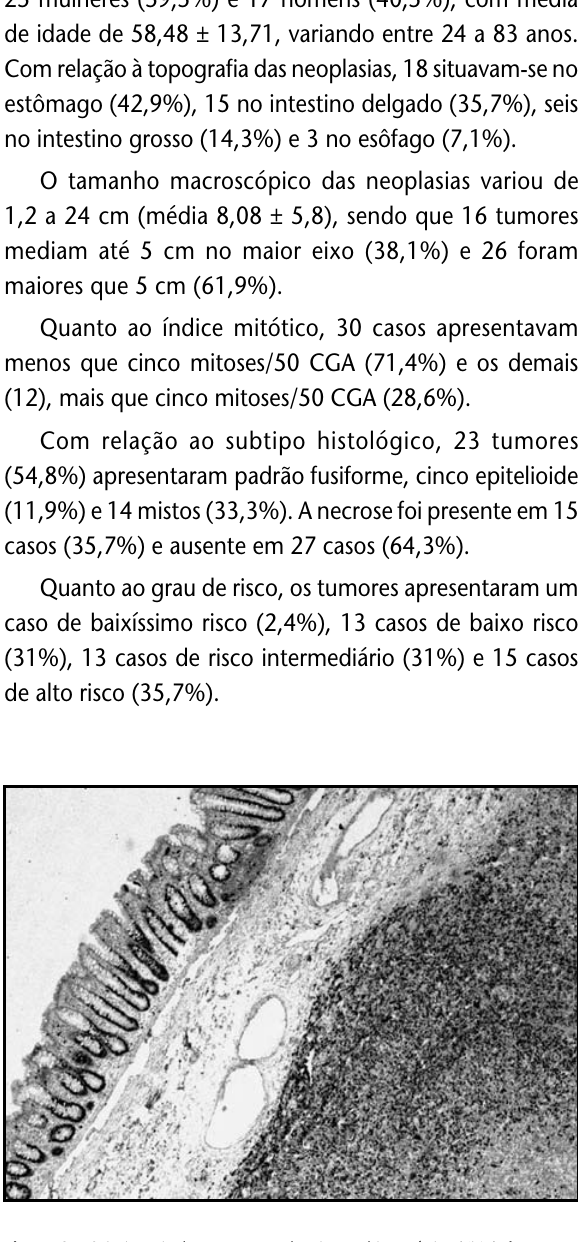
Figura 3 – GIST intestinal. Marcação nuclear imuno-histoquímica (Ki67), fortemente positiva